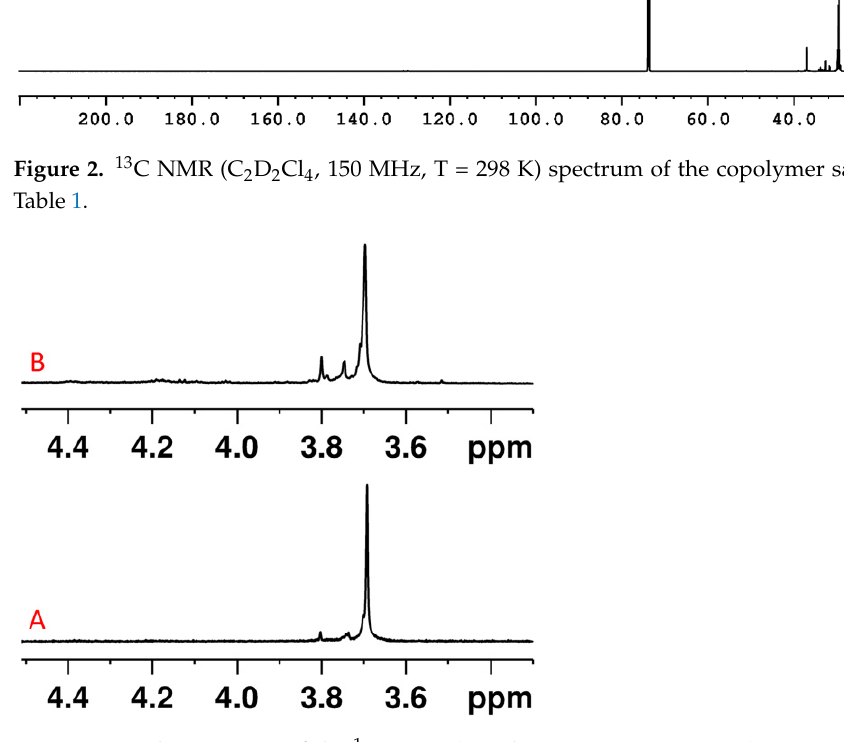
Figure 2. 13 C NMR (C 2 D 2 Cl 4 , 150 MHz, T = 298 K) spectrum of the copolymer sample of run 2, Table 1.